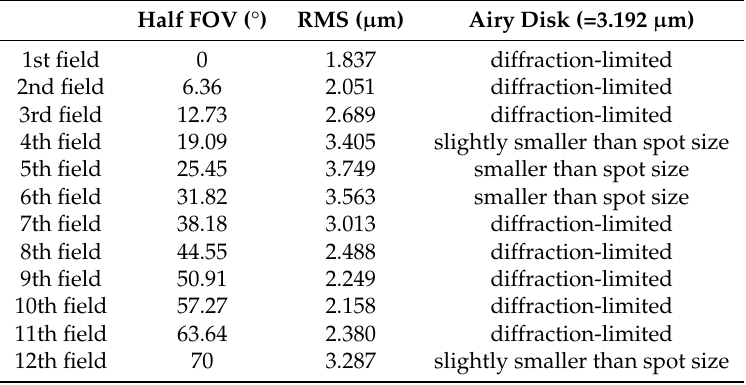
Figure 2. Spots sizes at λ = 900 nm, for fields between 0° and 70°. Airy disk radii (black circles) equal 3.192 µ m. When considering the spots, the system shows a good image quality. OBJ (in degrees) defines the object field and IMA (in mm) defines the image height of the centroid on the detector. The sampling of these 12 fields has been chosen such that they are separated by the same angle. Table 2. RMS spots sizes for the different fields in Figure 2. At 900 nm, only the 5th and 6th fields have a spot size exceeding that of the Airy